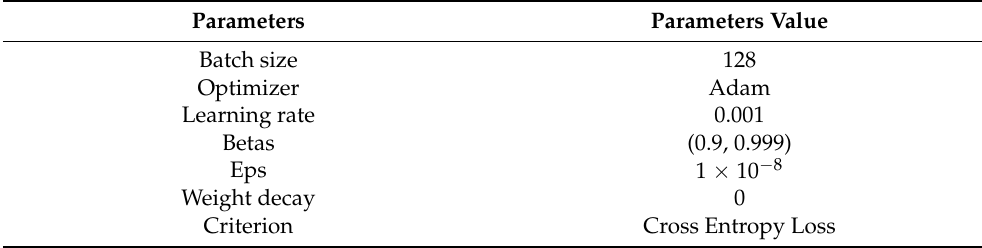
Table 2. Hyperparameters of different TL